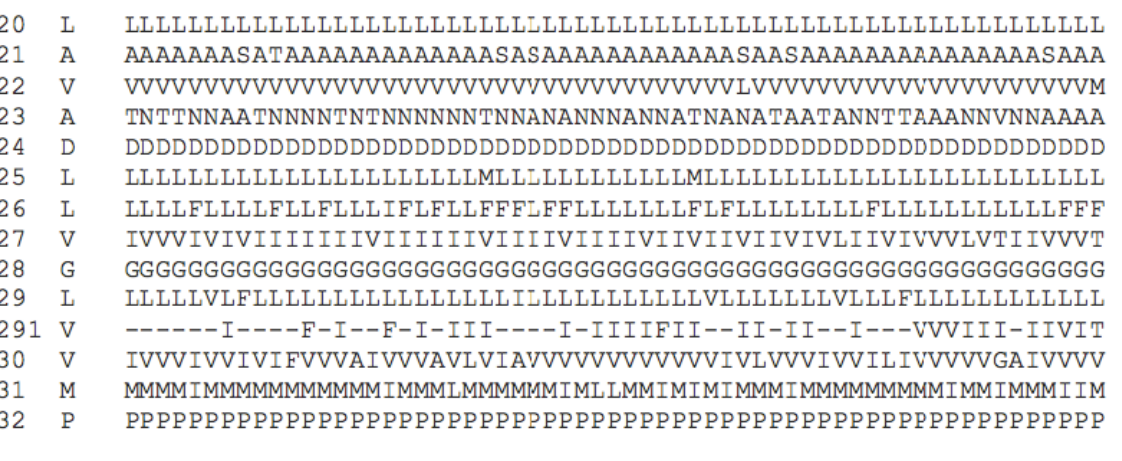
Figure 5. Fourteen consecutive residues in helix II (starting at the conserved L at position 220) extracted from the trace amine sequence alignment from the GPCRDB. From left to right the columns contain the GPCRDB sequence number, the consensus sequence at that position, and the amino acid at that position in each of the 61 sequences in the GPCRDB trace amine family 16. Figure copied with permission from Isberg et al.